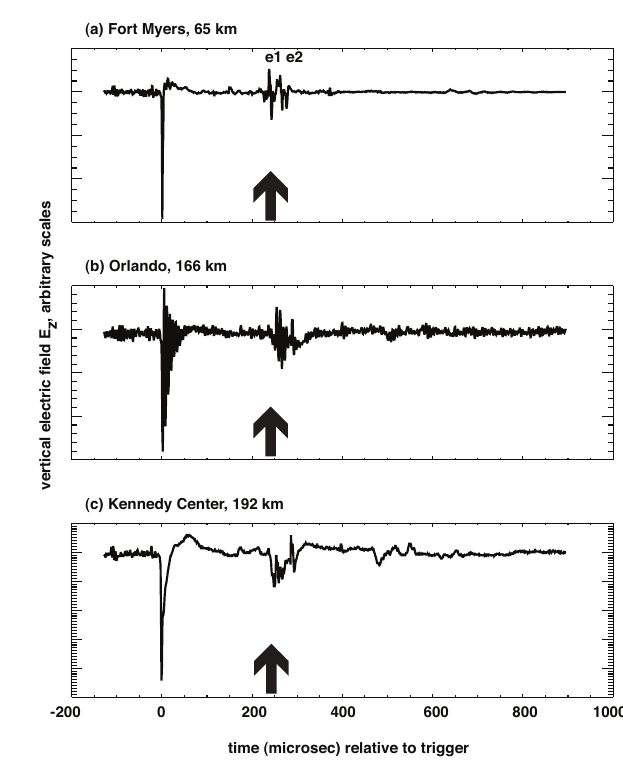
Fig. 5. Similar to Fig. 4, but for the coincidence in line #6 of Ta- ble 2. As in Fig. 4, the stroke automatically classified as an “NBE” is actually a negative cloud-to-ground